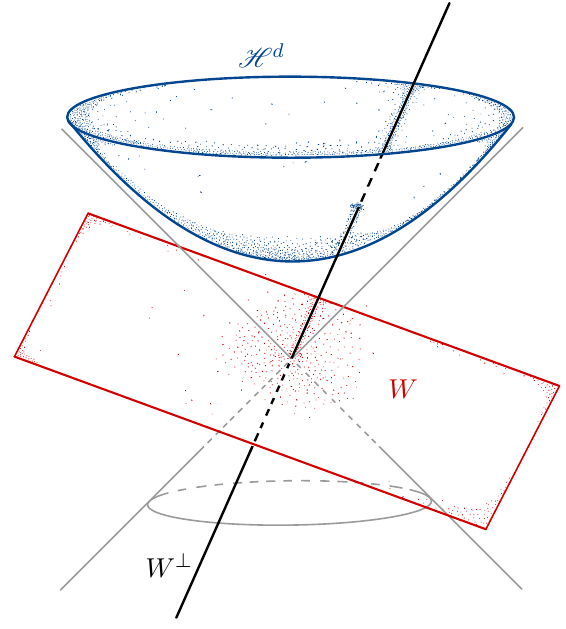
Figure 4 . Ti ∼ = AdSC fibering over hyperbolic